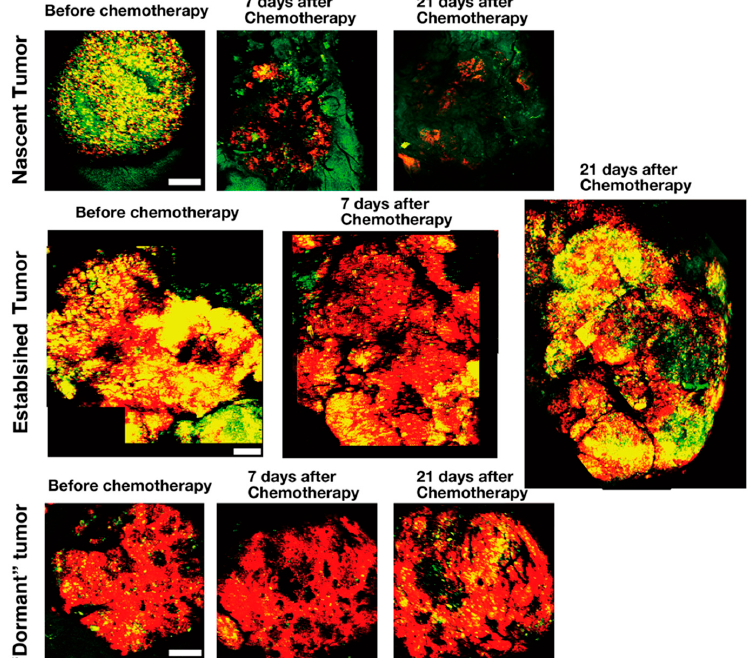
Figure 6. Response to cytotoxic chemotherapy of tumors at different stages, visualized by FUCCI. Representative images of FUCCI-expressing tumors treated with cisplatinum. The cells in G 0 / G 1 , early S, or late S/G 2 /M phases appear red, yellow, or green, respectively [8]. Scale bar; 500 μ m.